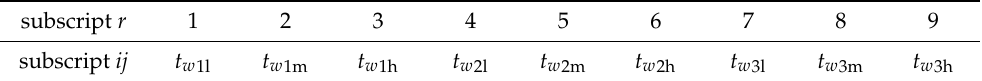
Table A4. The match between a coding mix with a subscript ( r ) and with two subscripts ( ij